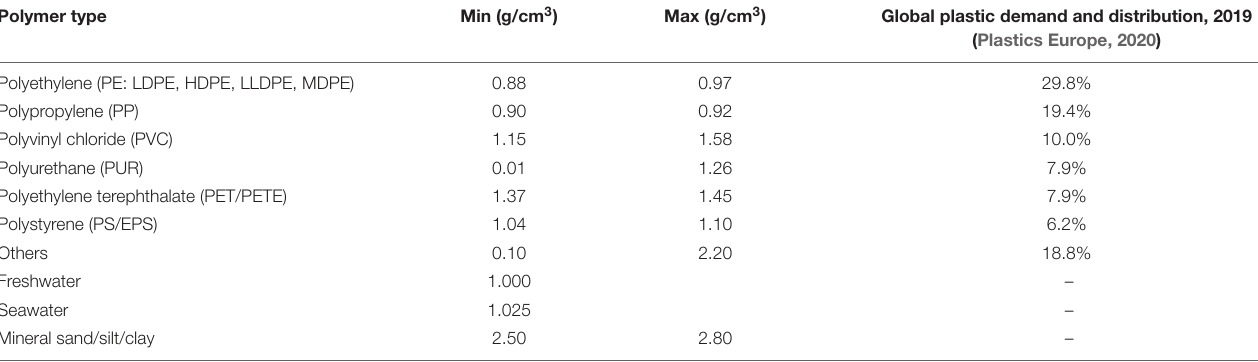
TABLE 1 | Density of high-demand plastics (Harper and Petrie, 2003), seawater (25 ◦ C, salinity of 35 g/kg, 1 atm pressure), freshwater (4 ◦ C), and common range for mineral sediments. Polymer type Min (g/cm 3 ) Max (g/cm 3 ) Global plastic demand and distribution, 2019